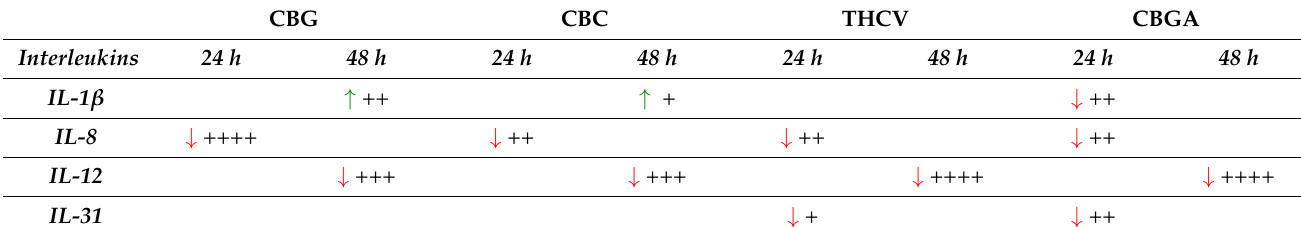
Table 1. Summary of the most significant effects of pCBs on cytokine release after HaCaT cell treat- ment with LPS for 24 h and 48 h. Legend: = no significant effect; ↑ significant increase; ↓